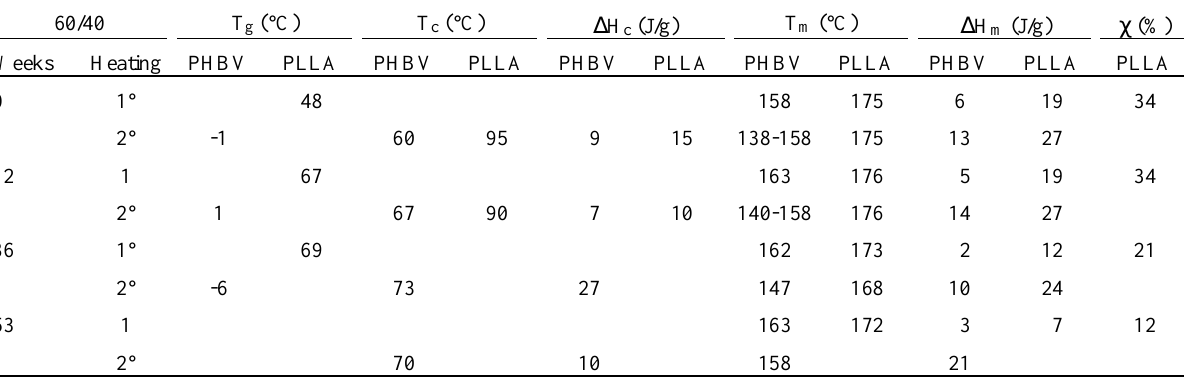
Table 3. Glass Transition (T g ), Crystallization (T c ) and Melting (T m ) Temperatures; Crystallization ( ∆ H c ) and Melting ( ∆ H m ) Enthalpies; Crystallinity